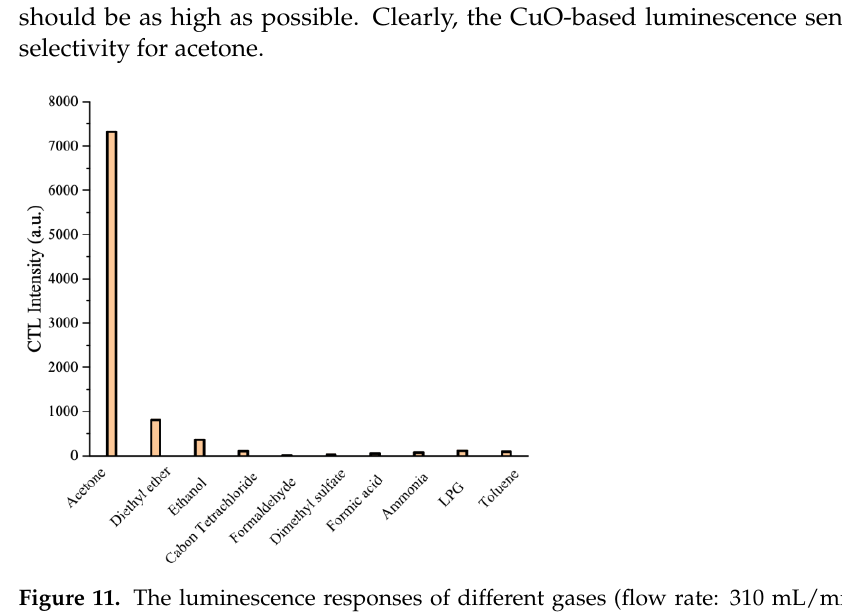
Figure 11. The luminescence responses of different gases (flow rate: 310 mL/min, temperature: 220 °C, wavelength: 590 nm, concentration: 1200 ppm).